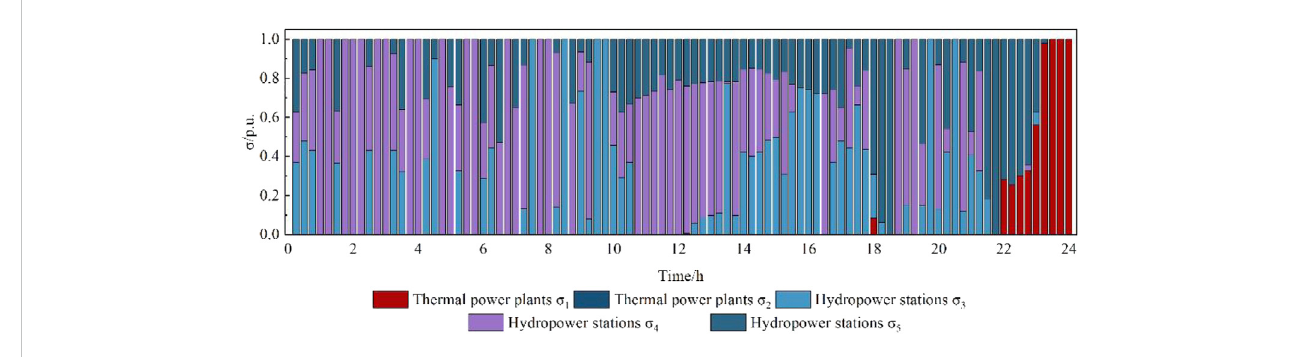
FIGURE 7 Intra-day optimization results of σ on January 22.